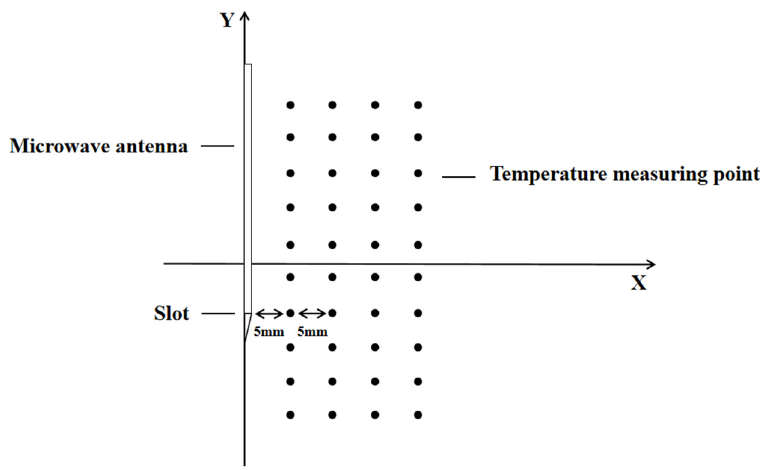
Figure 1. Distribution map of microwave antennas and temperature measurement points.